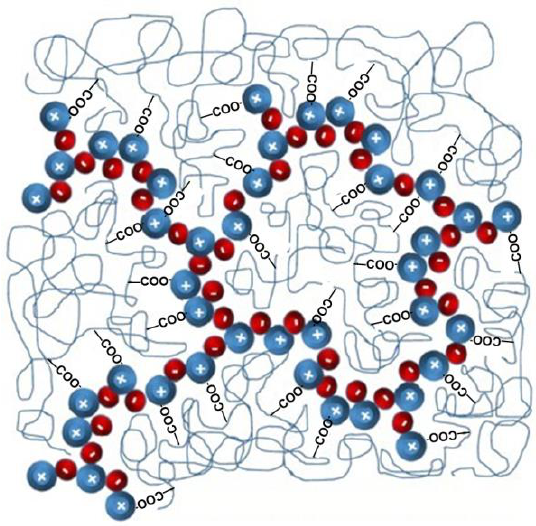
Figure 1. Targeted nano/microstructure of LIonomers.